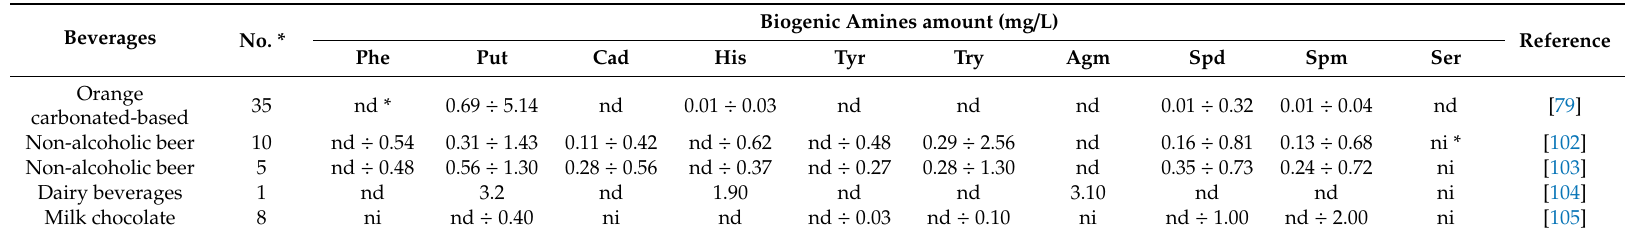
Table 6. Biogenic amine amount in soft